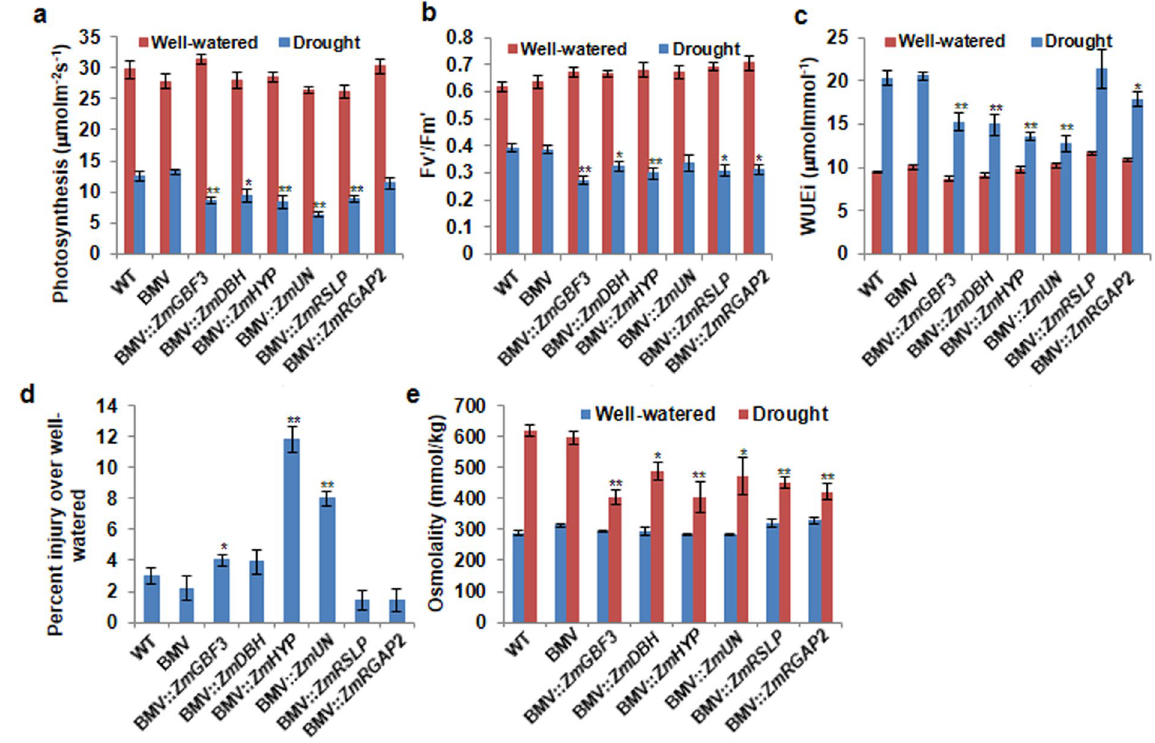
Figure 2. Reduced physiological performance and cellular tolerance of gene silenced maize plants to drought stress. Five plants at 14 dpi were subjected to drought stress and stress response was measured on fifth day. Photosynthesis rate ( a ), Efficiency of PSII in light adapted leaves ( b ), and Instantaneous water use efficiency (WUEi) ( c ) were measured using portable photosynthesis system. Cell membrane stability ( d ) and Osmolality ( e ) were measured from the leaf tissue. Cell membrane damage was calculated as per cent injury. BMV- inoculated plants were used as reference for statistical analysis. The values are means ± SE (n = 5). * and ** indicate significant difference from BMV-inoculated plants at P ≤ 0.05 and P ≤ 0.01, respectively. WT, non- inoculated; BMV, vector inoculated; all others with BMV:: followed by gene name are respective gene-silenced